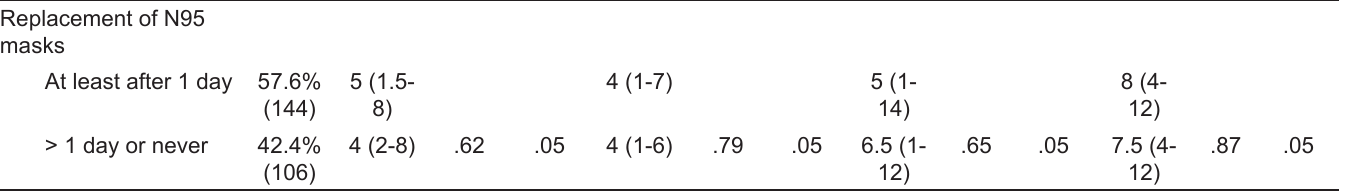
Table 5. Positive outcomes as a result of COVID-19.